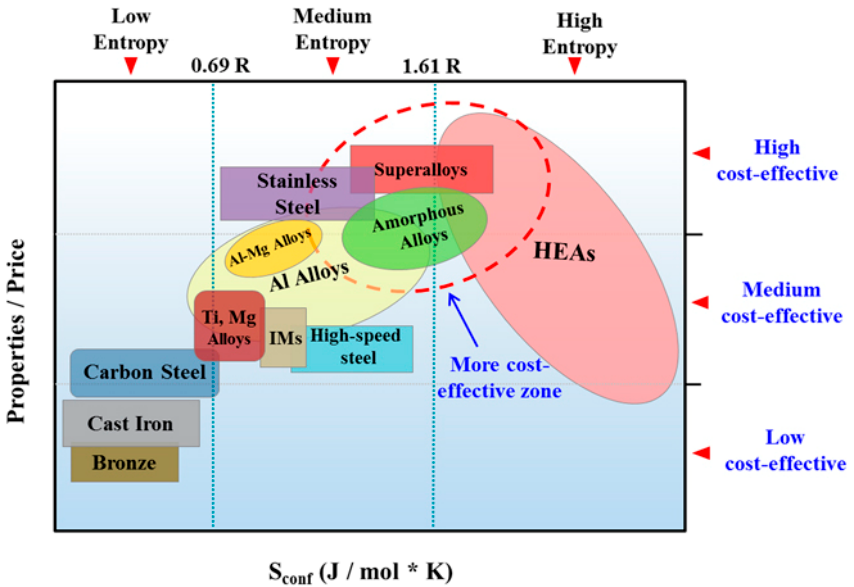
Figure 3. Relationship between property/price ratio and the configurational entropy of common alloys (this figure is from Reference [14]; IMs: Intermetallics or metallic compounds).